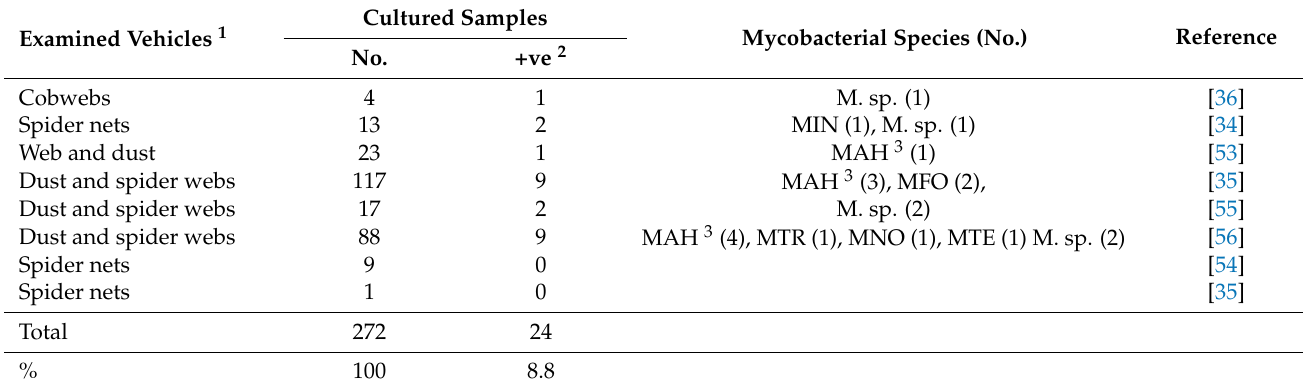
Table interpretation. MAH = M. avium ssp. hominissuis ; M. = Mycobacterium ; sp. = species; MTR = M. triviale ; MNO = M. nonchromogenicum ; MTE = M. terrae ; MFO = M. fortuitum ; MIN = M. intracellulare ; 1 as vehicles are described in published source; 2 +ve = positive results; 3 identified according to Slana et al.